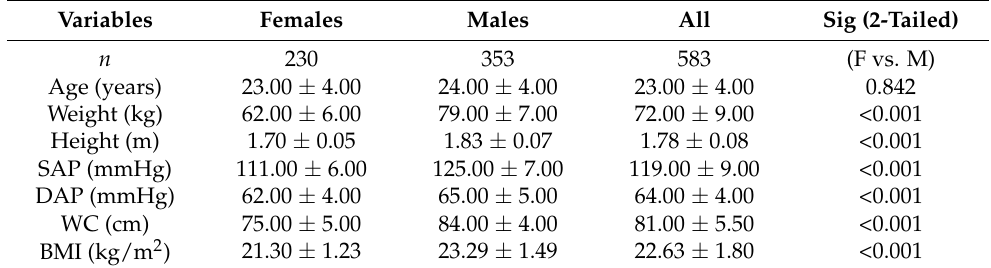
Table 2. Anthropometric data: summary statistics (median ± MAD) and Mann–Whitney test. Variables Females Males All Sig (2-Tailed)